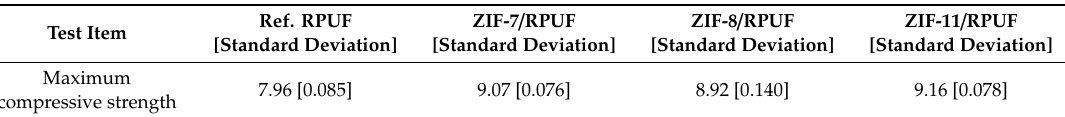
Figure 4. Compressive strength of Ref. polyurethane foams (RPUF), ZIF-7 / RPUF, ZIF-8 / RPUF and ZIF-11 / RPUF. Table 1. The maximum compressive strength of